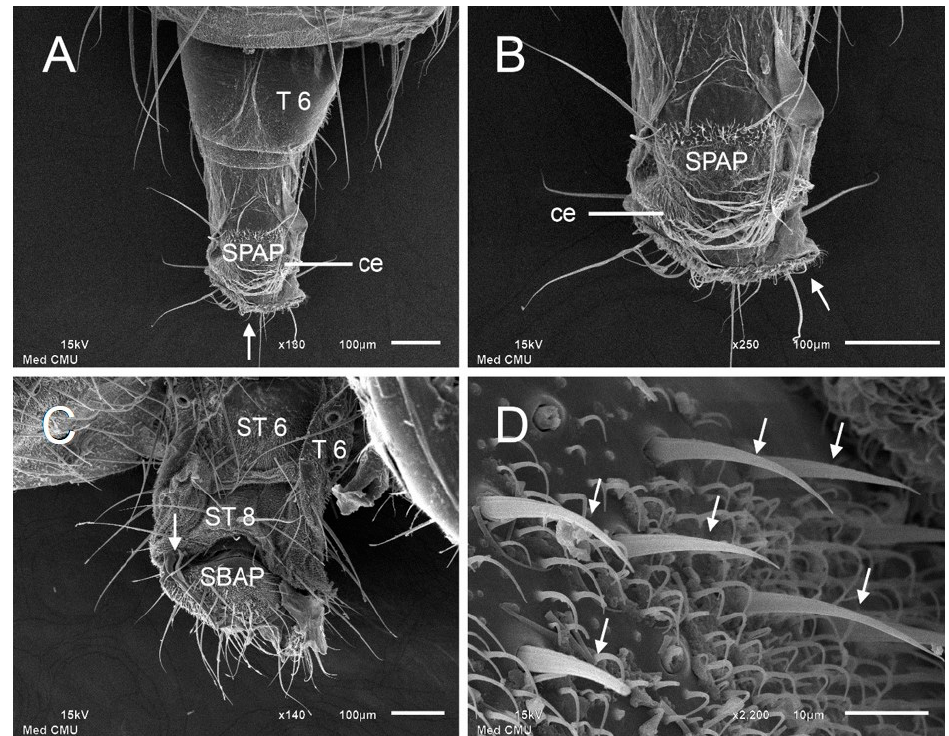
Figure 4. SEM micrographs of ovipositor of Stomorhina discolor . ( A ) Dorsal view of ovipositor showing tergite 6 (T6), supra-anal plate (SPAP), and cercus (ce). Gonopore at apex of ovipositor (arrow); ( B ) High magnification of dorsal view of ovipositor showing more detail of supra-anal plate (SPAP) and cercus (ce). Gonopore (arrow); ( C ) Ventral view of ovipositor showing side of tergite 6 (T6), sternite 6 (ST6), sternite 8 (ST8), and subanal plate (SBAP). Gonopore (arrow); ( D ) High magnification of subanal plate (SBAP) showing sensilla basiconica (arrows) and smaller microtrichia.